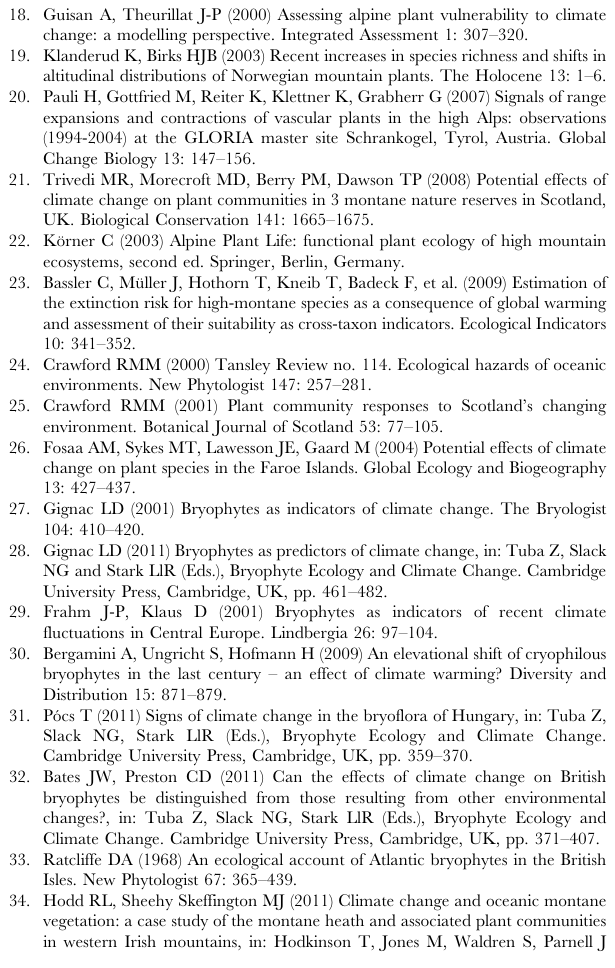
Curve and Kappa/TSS is Cohen’s Kappa statistic (K) and True Skill Statistic (TSS) respectively. Table S4 A: AUC, Kappa and TSS values for all species using an ensemble modelling approach in BIOMOD2, from models created using both climate and topography variables and climate variables only. Model predictive accuracy is acceptable when AUC . 0.7 and Kappa/TSS . 0.4 (Table S3). Sensitivity and specificity presented only for models created using both climatic and topographic variables. B: Correlation coefficients between the five model predictive performance statistics: Cohen’s Kappa statistic (K), True Skill Statistic (TSS), Area Under the Curve (AUC) of the Receiver Operating Characteristic, Sensitivity and Specificity scores. Table S5 Range changes (%), derived from ensemble of models produced in BIOMOD2, for all species under conditions of unlimited and limited dispersal. Table S6 Mean range changes (%) ± standard error of the mean, under conditions of unlimited and limited dispersal, under the categories of plant type, communi- ty, biome and eastern limit.